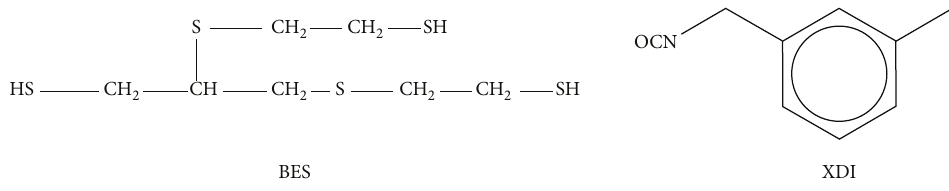
Figure 1: Chemical structure of BES and